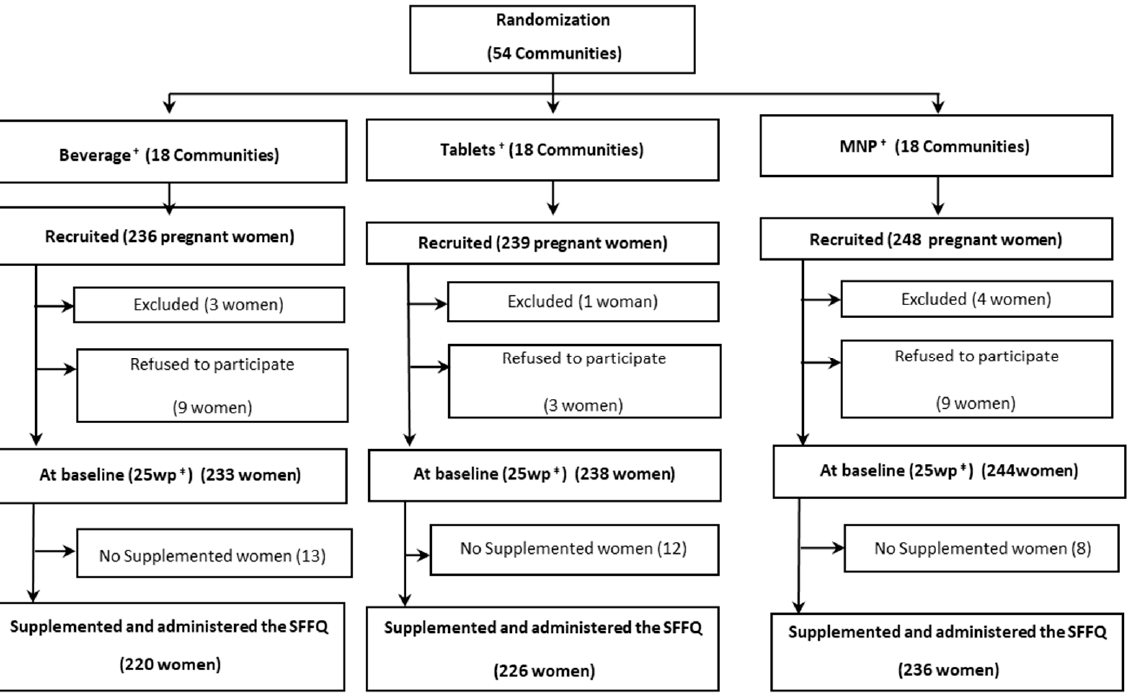
Figure 1. Participant recruitment, exclusion and inclusion at baseline †,‡ . † Beverage: fortified beverage, Tablets: micronutrient tablets, and MNP: micronutrient powder. ‡ 25 wk: 25 weeks of pregnancy.